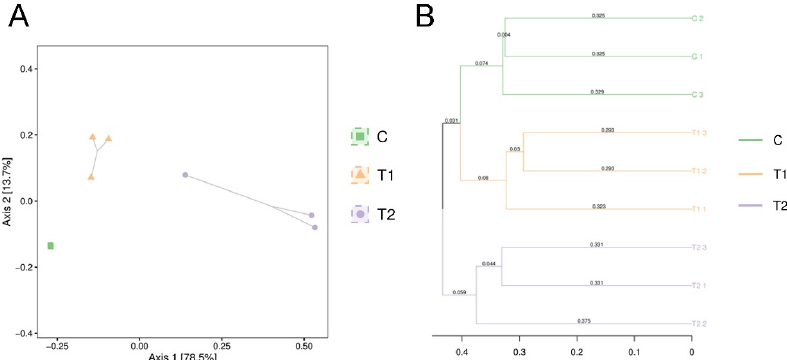
Figure 7. Beta diversity of the gut microbiota among different groups of gibel carp exposed to aflatoxin B1. ( A ) The principal co-ordinate analysis (PCoA) of the bacterial community at the operational taxonomic unit (OTU) level. ( B ) The hierarchical clustering tree was calculated using the unweighted pair group method with arithmetic mean (UPGMA) method. C: control diet, T1: 50 µg/kg AFB1, T2: 100 µg/kg AFB1.